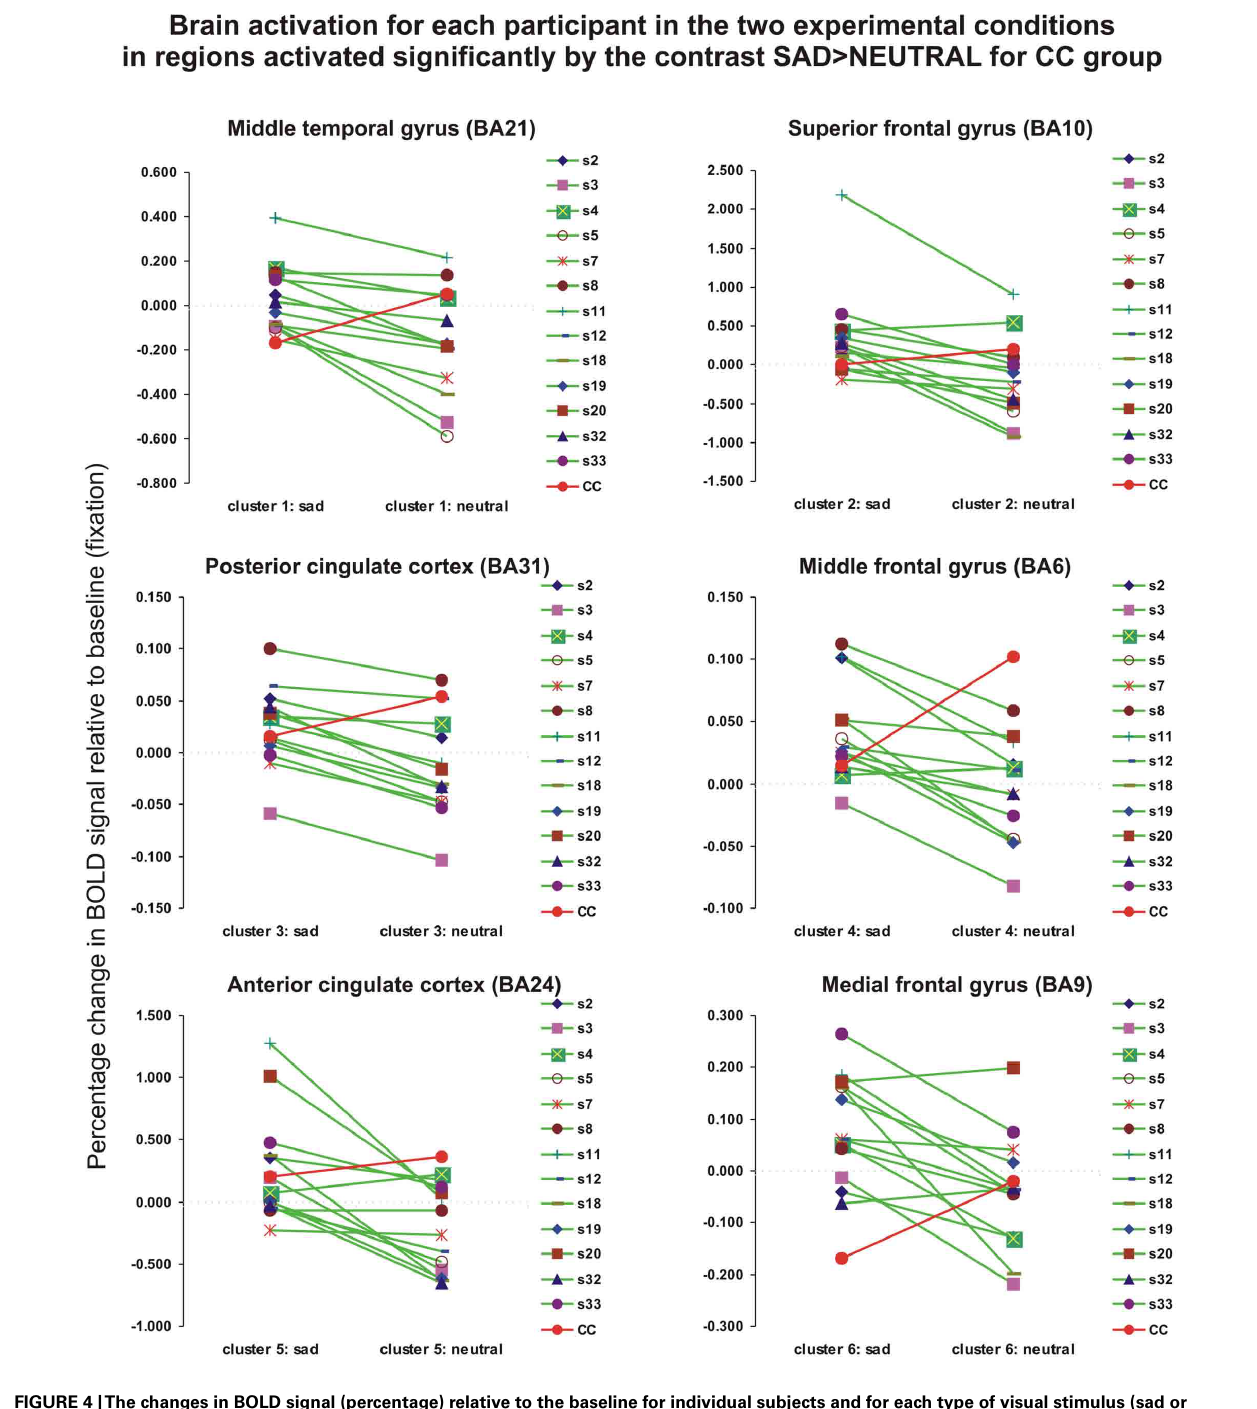
FIGURE 4 |The changes in BOLD signal (percentage) relative to the baseline for individual subjects and for each type of visual stimulus (sad or neutral) in six regions of interest obtained in the contrast SAD > NEUTRAL at the group level (CC group). The detailed analysis of the BOLD signal change in each of the six clusters obtained in the CC group (green lines) revealed that the agCC patient had an opposite activation pattern (the red